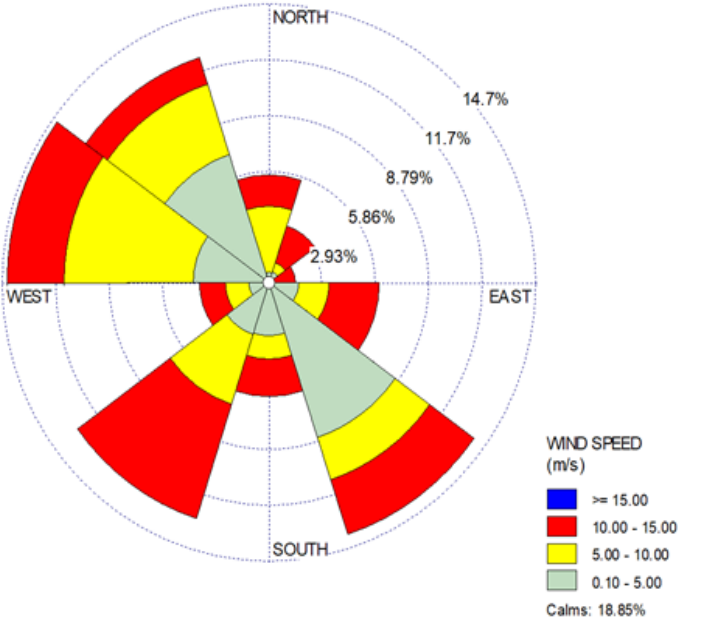
Figure 11. Wind direction graph based on data collected at Sost, Hunza, Gilgit, Jaglot and Chilas.